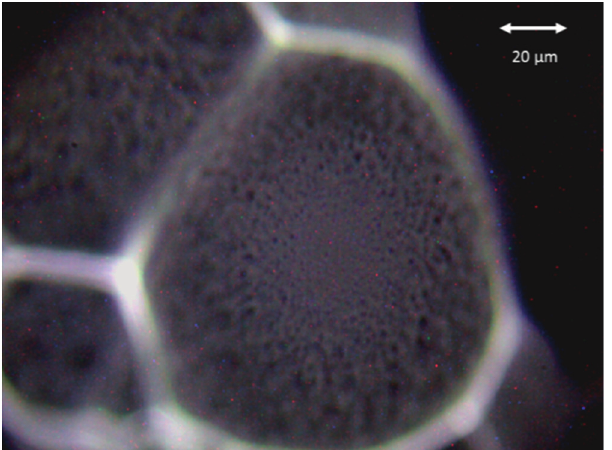
Figure 5. Image of a colony of Staphylococcus epidermidis